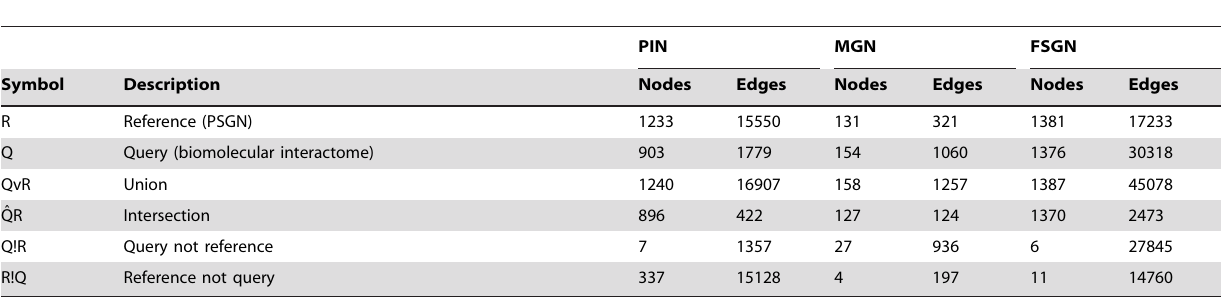
Table 6. Counts of nodes and edges in the comparison of PSGN and biomolecular interactomes.